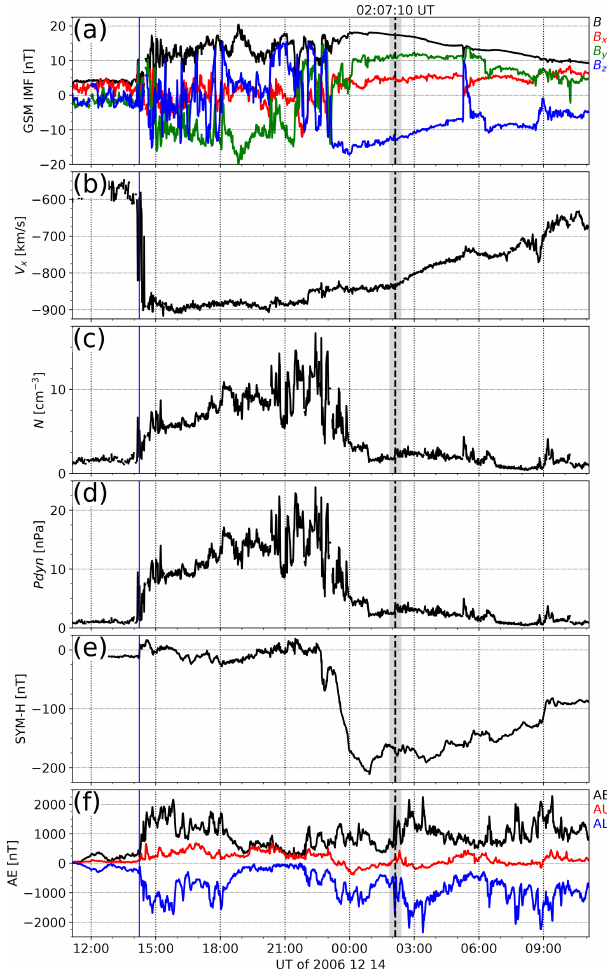
Figure 8. Data in a format similar to Fig. 6 from − 15 to + 9h around the event on 15 December 2006 at 02:07:10UT. The vertical blue line indicates a SC at